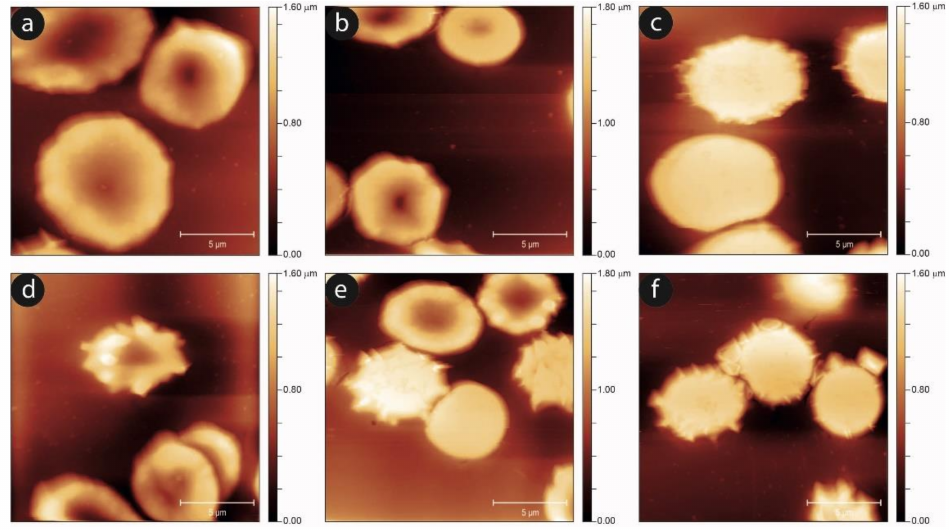
Figure 7. Typical AFM images of the RBCs’ morphology for static controls (upper panels) and mechanically stimulated samples (lower panels) after three ( a , d ), six ( b , e ), and nine days ( c , f ) of aging. Altered morphologies can be observed more often, especially at the longer times, in mechanically stimulated samples than in static